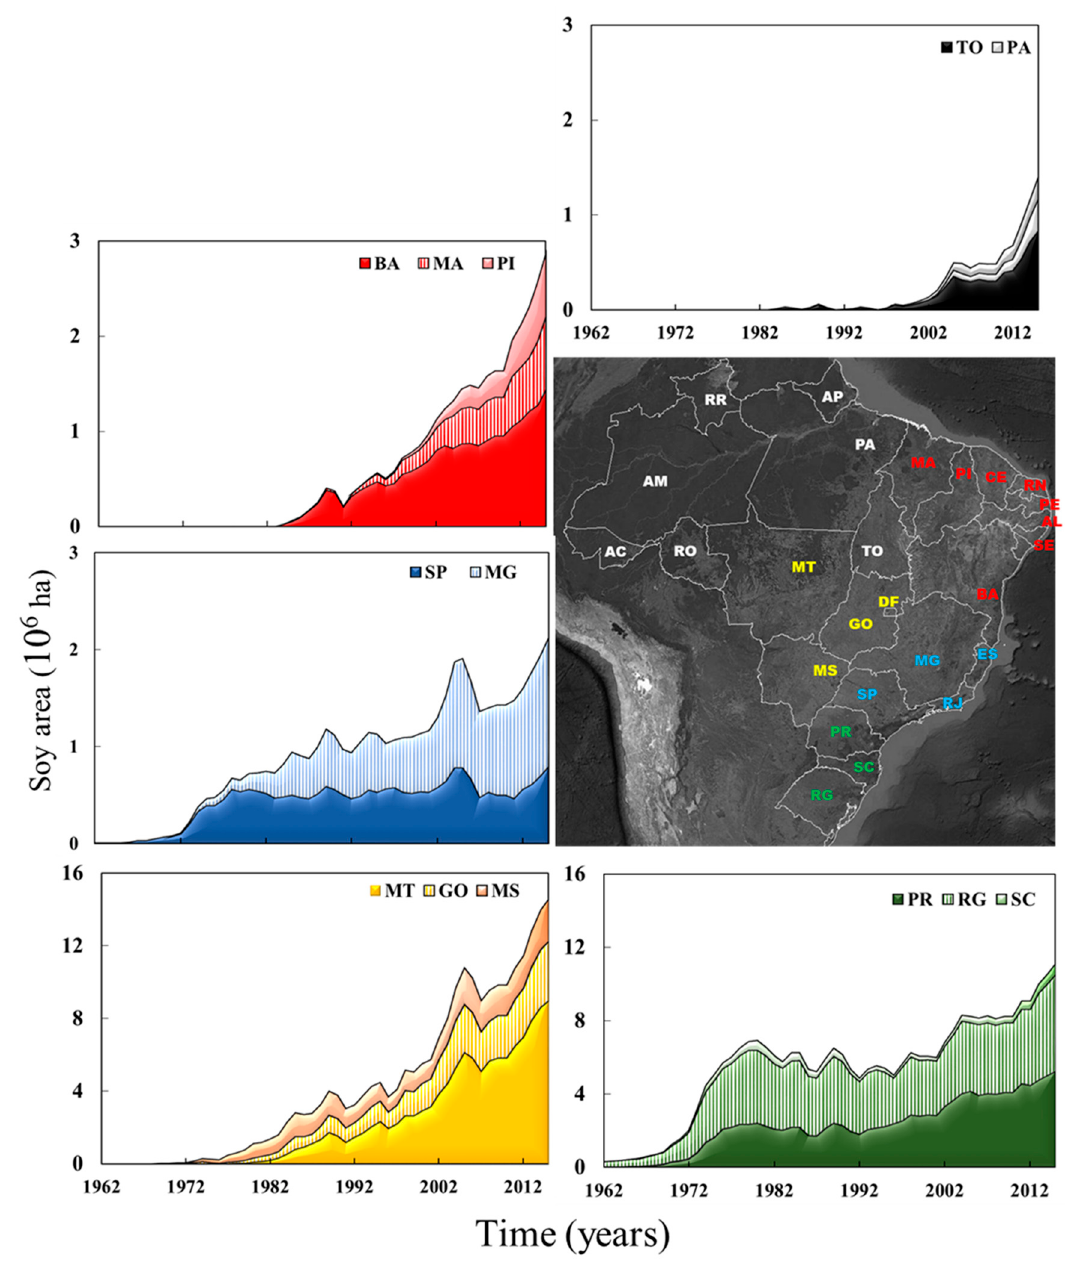
Figure 1. On the right, map of Brazil with state borders in white and abbreviations of states in colors illustrating major geographic regions: North—white, Northeast—red, Center-West—yellow, Southeast—blue, South—green. Graphs around the map show annual variability of soy-harvested areas (ha) in selected states.